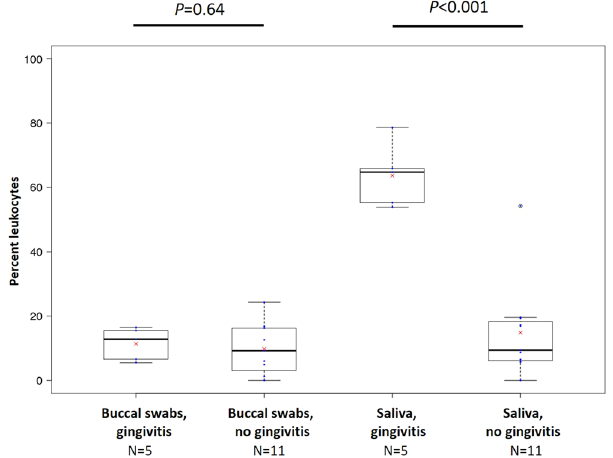
Figure 5. Box and whisker plots of the presence of leukocytes in saliva and buccal swabs in relation to gingivitis. Numbers of participants in each category are indicated means are indicated with red